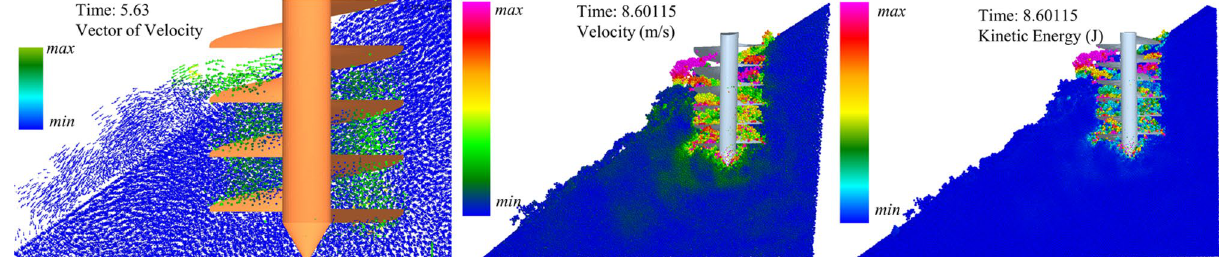
Figure 9. The disturbance of the soil effect by spiral blade.